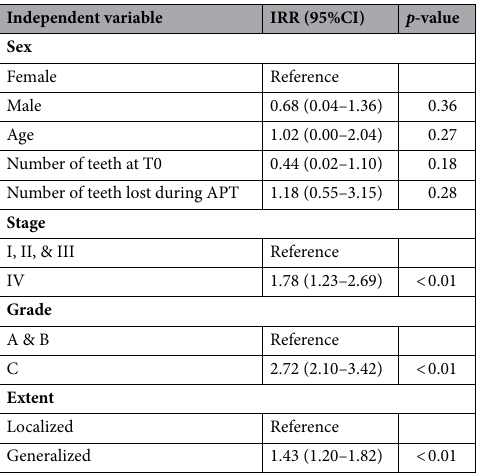
Table 7. Multivariate analysis (negative binomial regression) of the number of extracted teeth during SPT. Multivariate analysis (negative binomial regression) of the number of extracted teeth due to periodontitis per patient during SPT; analysis was corrected for the period of follow-up. APT active periodontal therapy; SPT supportive periodontal therapy; IRR incidence rate ratio; CI confidence interval; T0 start of